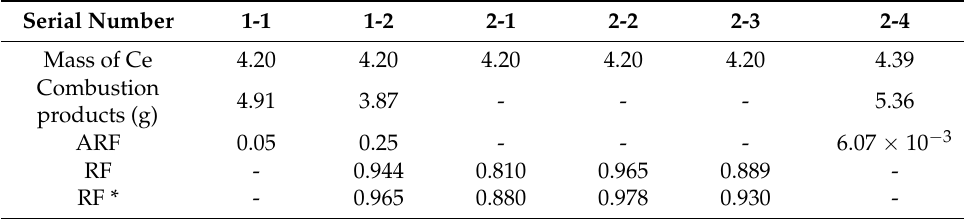
Table 10. Results of ARF and